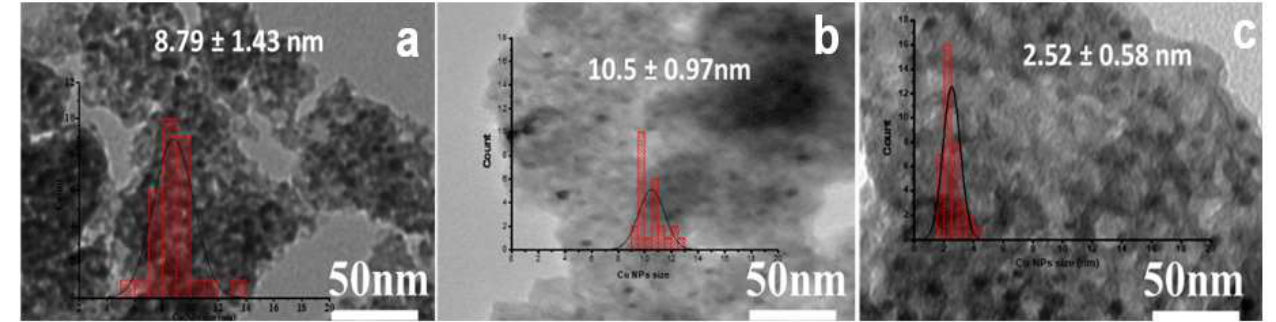
Figure 2. TEM images of various zirconia-based Pt catalysts ( a ) Pt/t-ZrO 2 , ( b ) Pt/S-ZrO 2, and ( c ) Pt/STA-ZrO 2 .